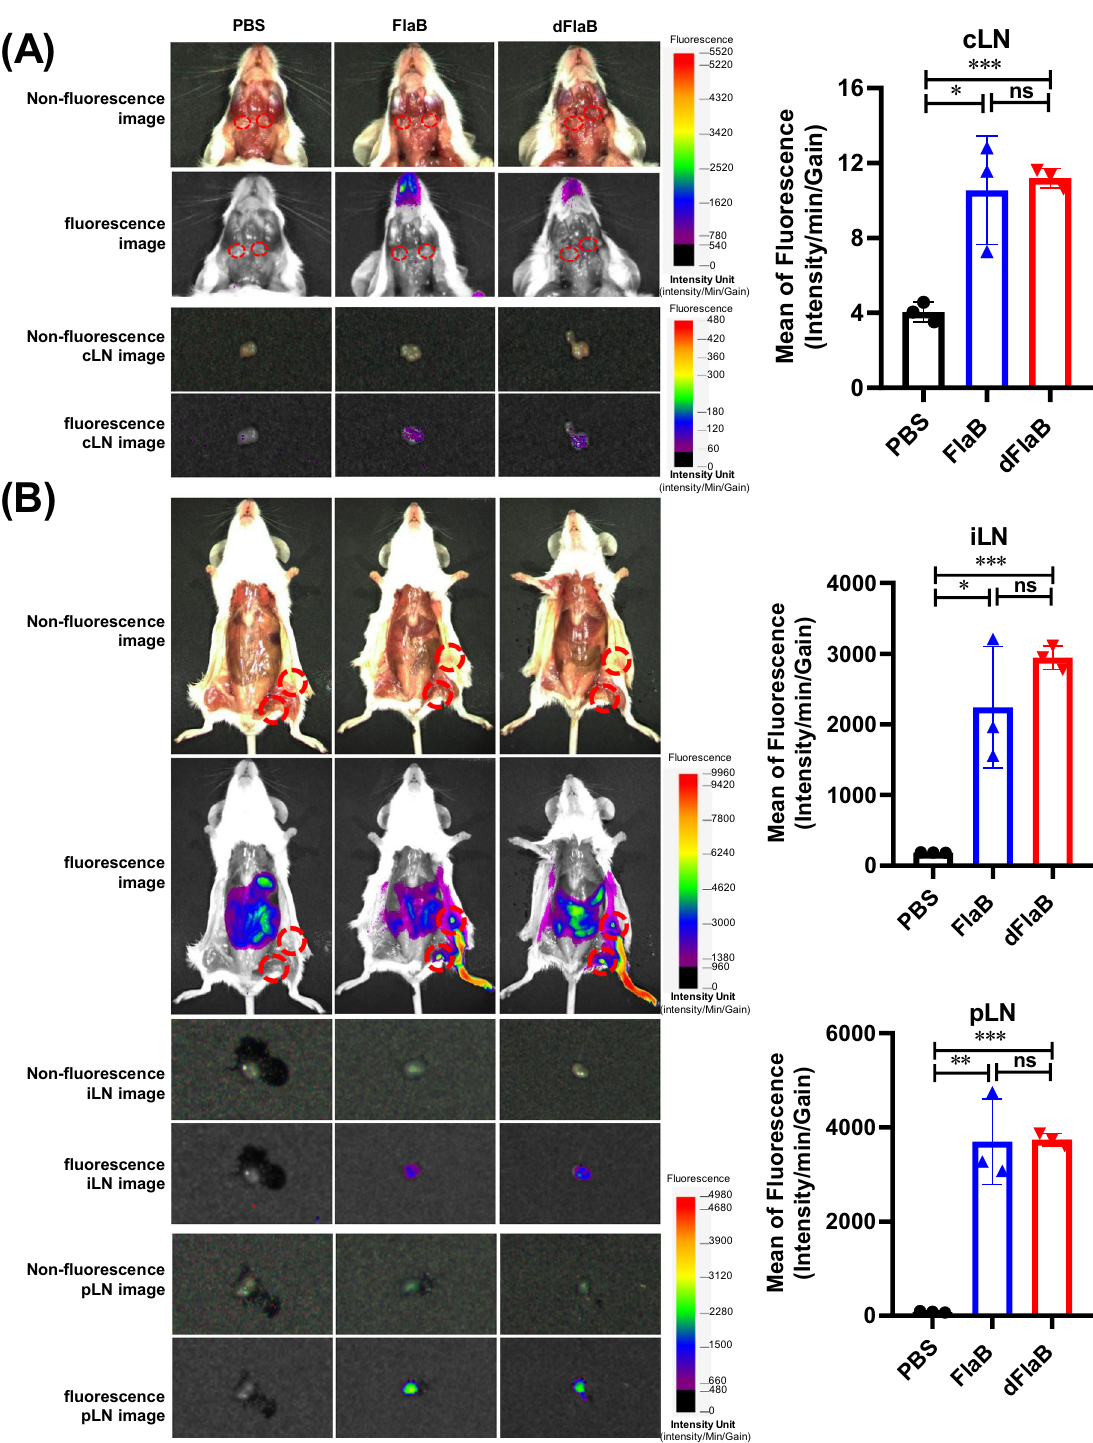
Fig. 4 Biodistribution of in vivo administered fl agellins. a Biodistribution of intranasally administered FlaB or dFlaB. BALB/c mice were intranasally administered with 100 μ g of FNR675-conjugated FlaB or dFlaB. b Biodistribution of FlaB or dFlaB administered by footpad injection. BALB/c mice were administered with 100 μ g of FNR675-conjugated FlaB or dFlaB. Six hours after the administration, the cLNs, iLNs, and pLNs were isolated to determine the biodistribution of the FlaB or dFlaB by measuring fl uorescence intensity as described in Materials and